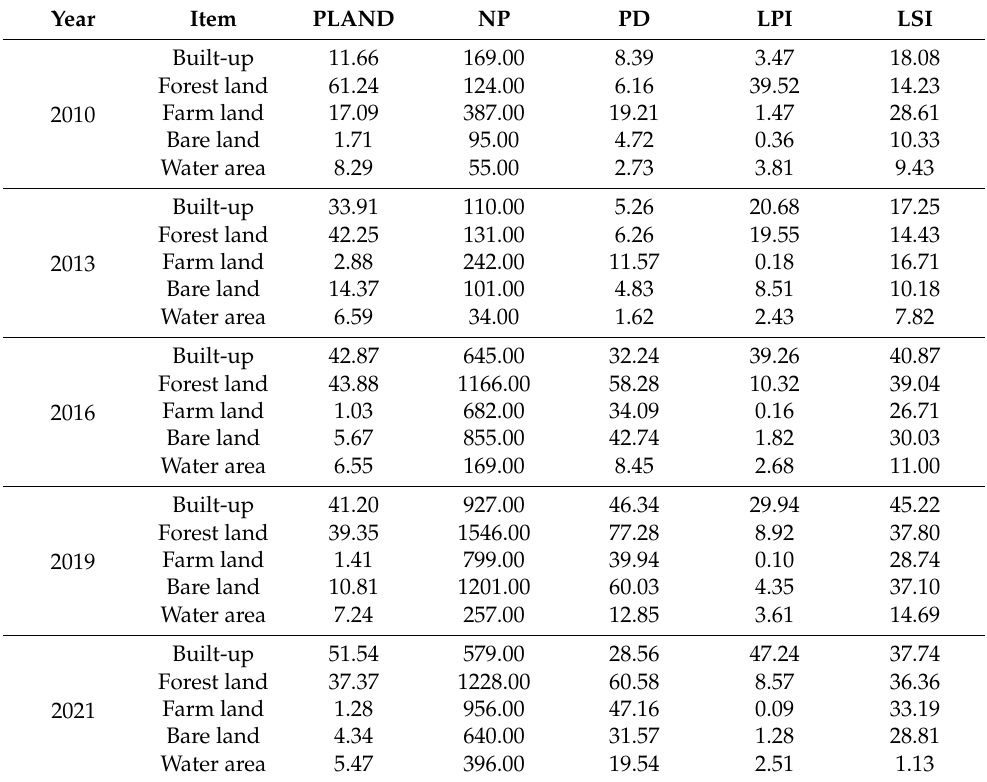
Table 8. Patche-type level landscape